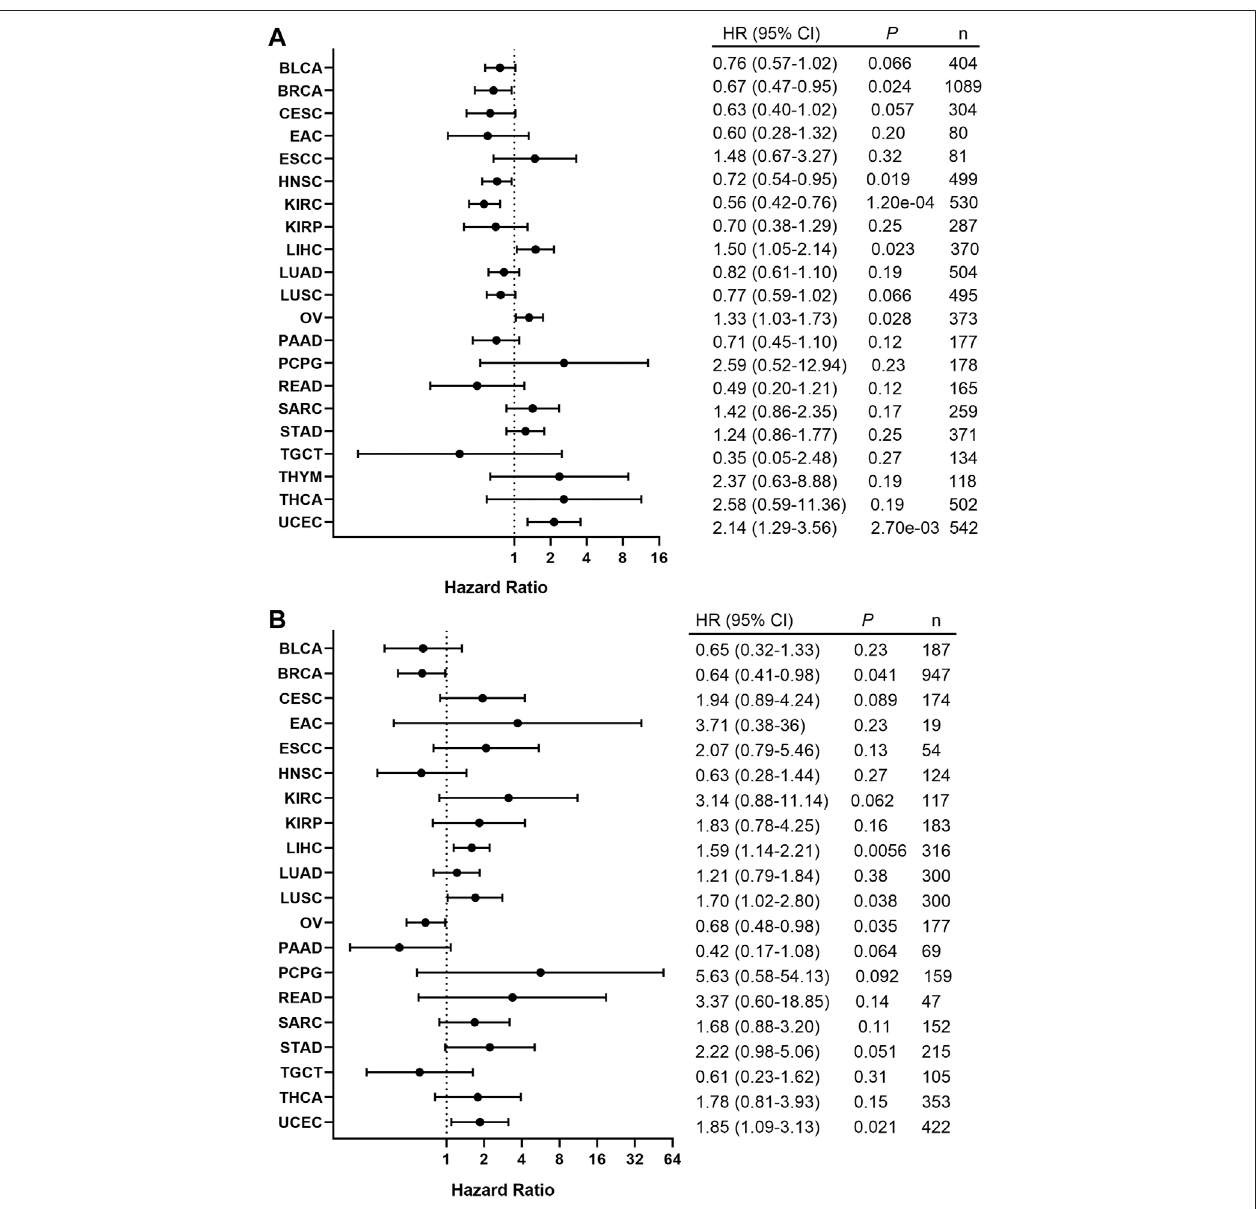
FIGURE 8 | Correlation between the BRAF expression and patient survival. (A) Forest plot of the association between BRAF expression and overall survival (OS) based on Kaplan-Meier Plotter. (B) Forest plot of the association between BRAF expression and relapse-free survival (RFS) based on Kaplan-Meier Plotter.